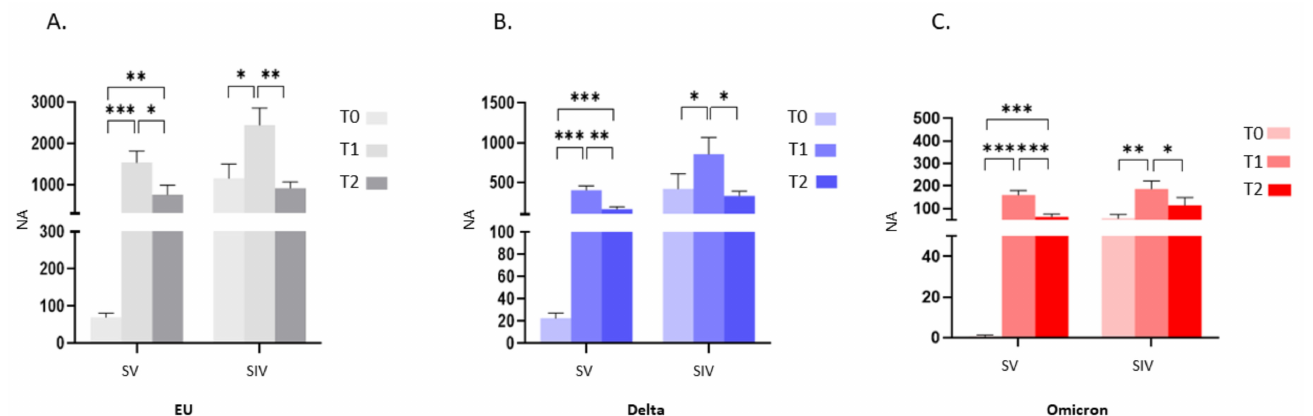
Figure 2. Plasma neutralizing activity (NA) trend over time. NA significantly increased from T0 to T1 and decreased from T1 to T2 against the EU ( A ), Delta ( B ) and Omicron ( C ) variants in both SV and SIV. Mean values ± SE are reported. * p < 0.05, ** p < 0.01, *** p < 0.001. Notably, the mean NA value at T0 in plasma from SIV was higher compared with SV against the EU strain (16.6-fold; p < 0.01) as well as the Delta (18.5-fold; p < 0.05) and the Omicron (70.9-fold; p < 0.01) variants (Figure 3A). Even more relevant, the percentage third dose booster administration (T0) was consistently higher in SV (EU: 6/53 =